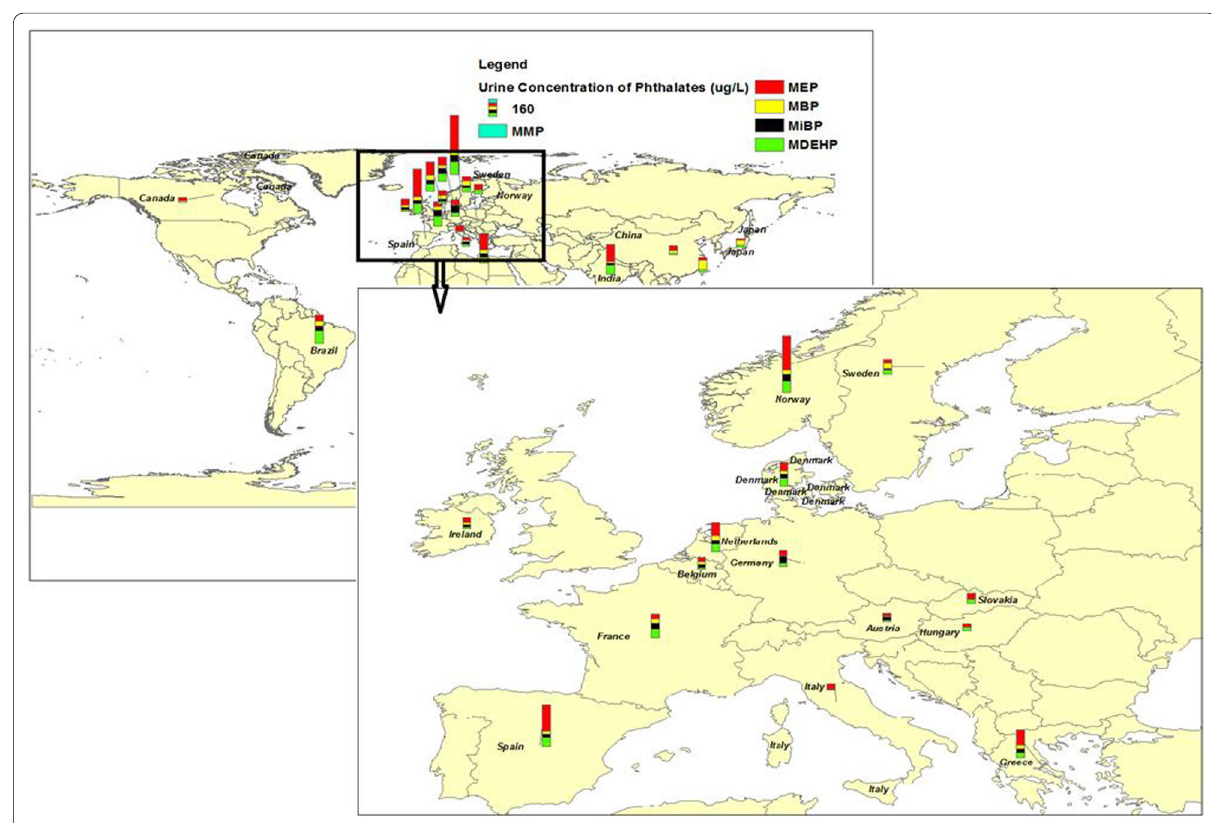
Fig. 4 A charted map showing the global distribution of women urine concentration of various metabolites of phthalates (MBP butyl paraben; MiBP Methyl-iso-butyl paraben; MMP Mono-methyl phthalate; MDEHP is a sum total of five metabolites including MEHP = = (mono-ethyl-hexyl phthalate), MEHHP (mono-(2-ethyl-5-oxy hexyl) phthalate)), MECPP(mono-(2-ethyl carboxy-pentyl)phthalate), and MCMHP (mono-(2-carboxy-methyl-hexyl) phthalate)). For detailed reference to the data for the plot (Wang et al.